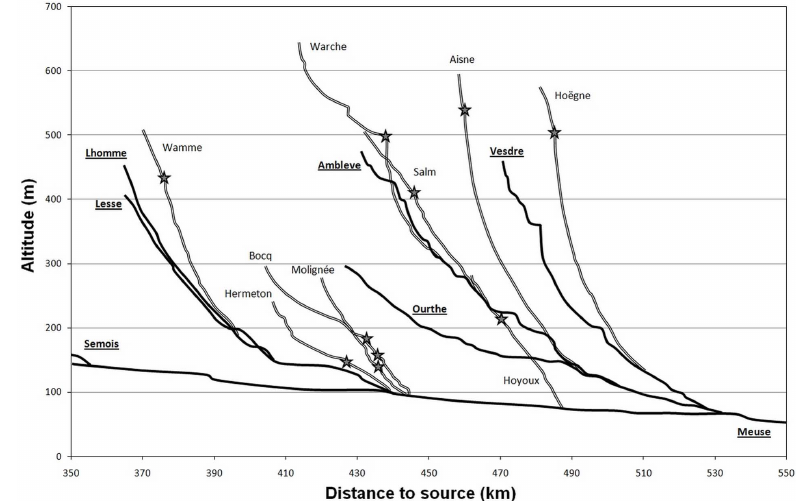
Fig. 4. Longitudinal profiles of the selected rivers within the Meuse river catchment. Double lines represent the selected rivers, bold lines the major streams of the region and stars indicate the position of the main knickpoint within each river profile. The Vierre profile is not represented in this graphic because of its distant location in the Semois river system.